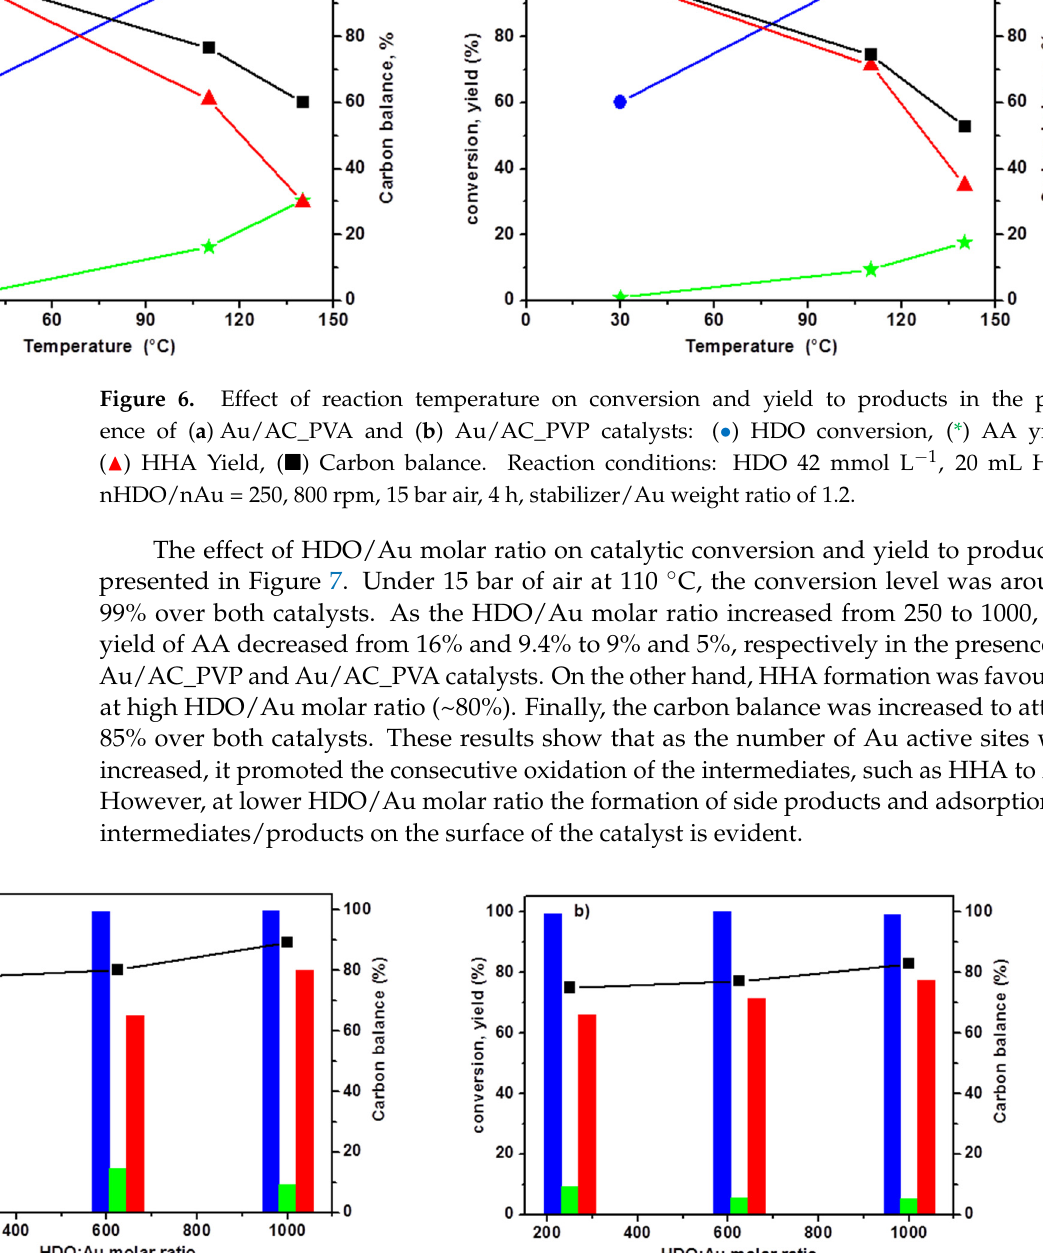
Figure 8 . Catalyst recyclability study: ( a ) Au/AC_PVA and ( b ) Au/AC_PVP: ( ■ ) HDO conversion, ( ■ ) AA yield, ( ■ ) HHA Yield, ( ■ ) Carbon balance. Reaction conditions: HDO 42 mmol L − 1 , 20 mL H 2 O, nHDO/nAu =250, 110 °C, 800 rpm, 15 bar air, 4 h, stabilizer/Au weight ratio of 1.2. Nonetheless, no leaching of Au was detected by ICP analysis. XPS and TEM characterizations were performed on the used catalysts to understand the possible reasons for deactivation. X-ray photoelectron spectroscopy (XPS) was performed on the fresh and spent catalysts. The Au 4f spectra of the Au/AC_PVA and Au/AC_PVP catalysts are displayed in Figure S8. XPS analysis confirmed the metallic state of the Au metal in the fresh and